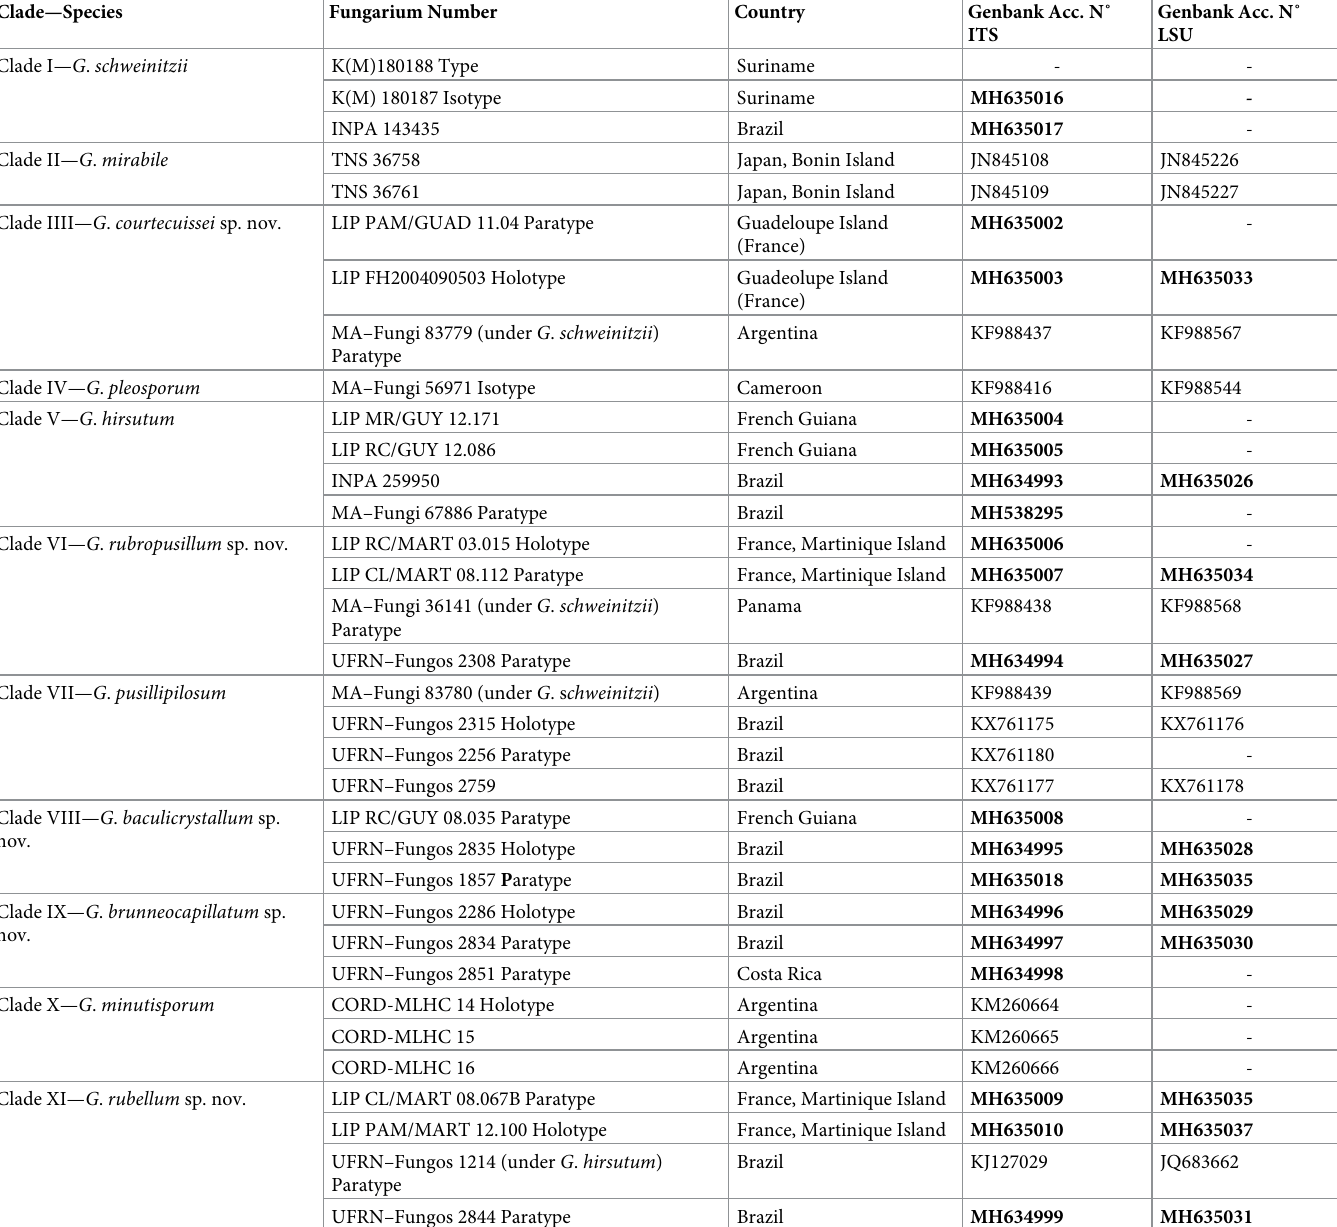
Table 1. Specimens and sequences included in this study. Clades as indicated from the bottom-up in Fig 1. Accession numbers in bold are from newly generated sequences.